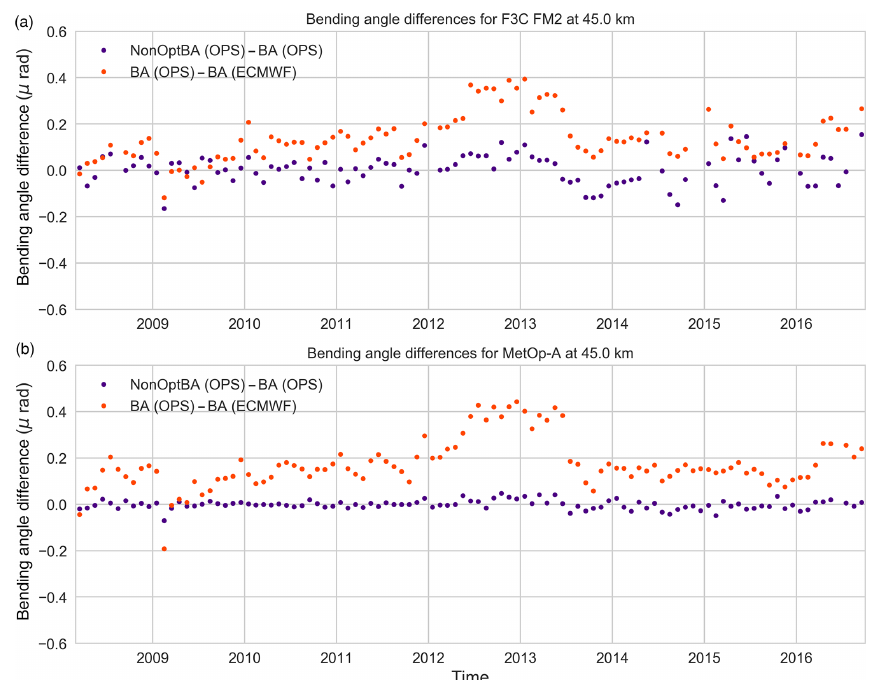
Figure 8. Monthly averaged differences between non-optimized (NonOptBA) and statistically optimized OPSv5.6 bending angle (BA) (violet dots) as well as between statistically optimized OPSv5.6 bending angle and co-located ECMWF bending angle (orange dots) shown for F3C FM2 (a) and for MetOp-A (b) at an impact altitude of